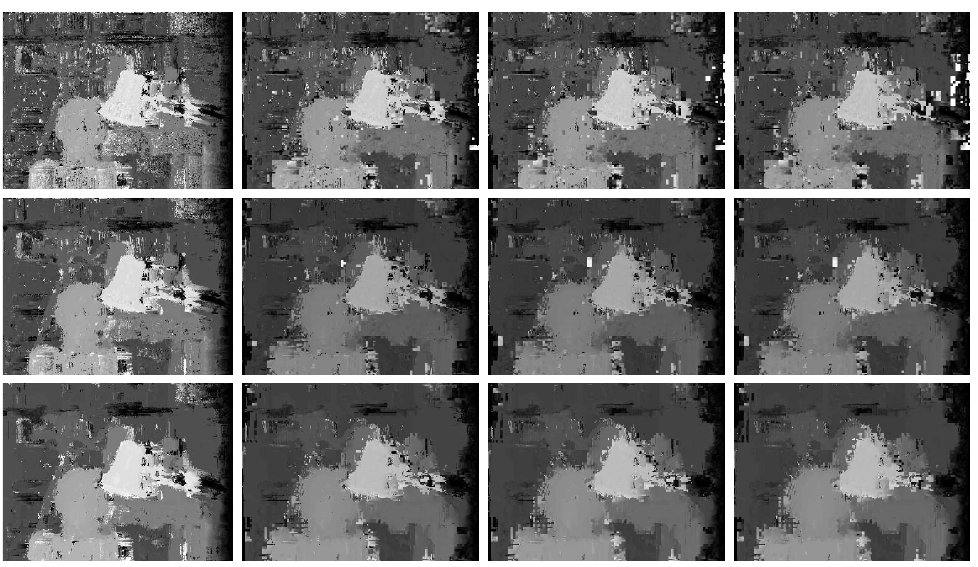
Figure 15. Disparity maps generated by multiresolution matching with δ ∈ { 0 , 0 . 2 , 0 . 3 , 0 . 4 } (columns from left to right) and windows of size 3 , 5 , 7 (rows from top to bottom), 6 pixels search